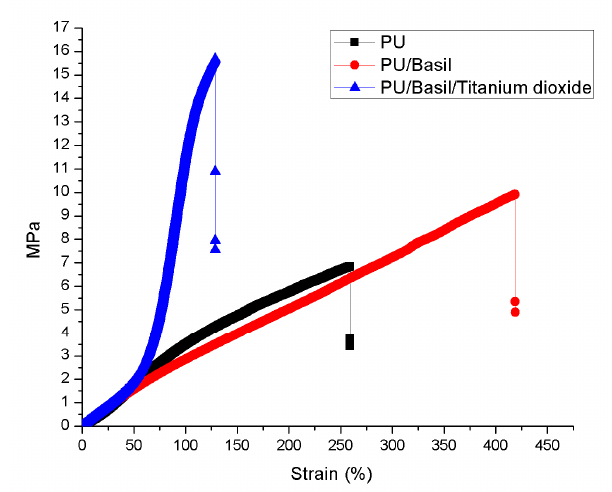
Figure 7. Tensile strength of PU, PU/BASIL and PU/BASIL/TiO 2.